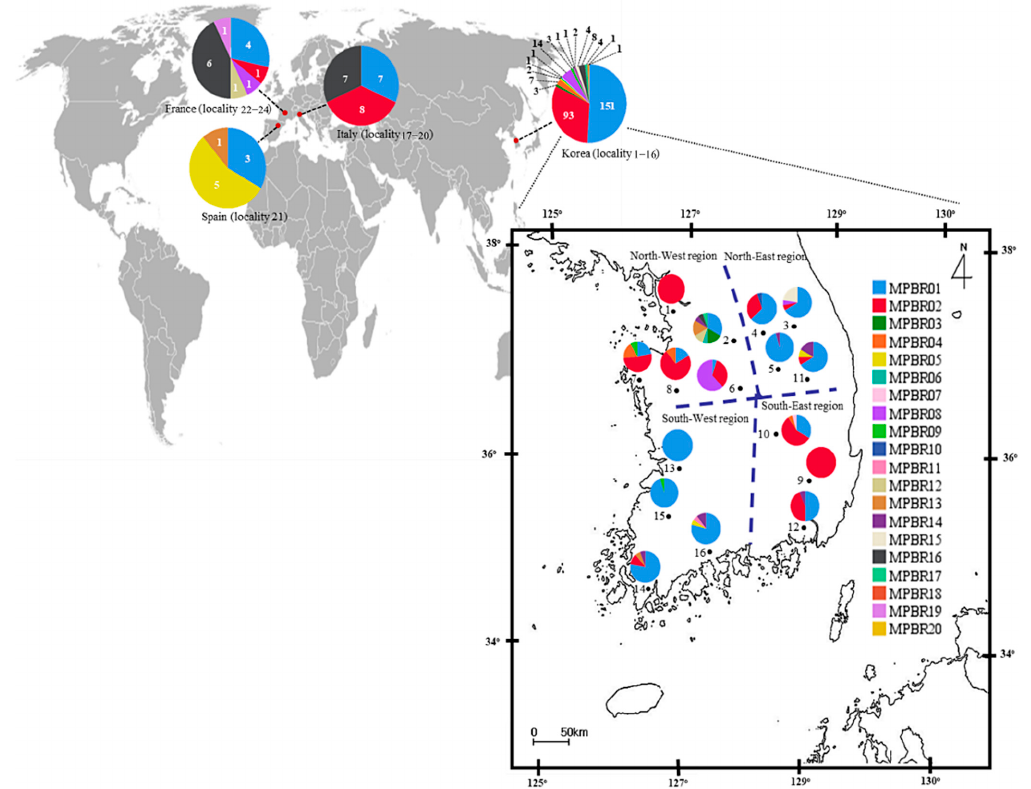
Figure 3. Distribution of the haplotypes defined based on the concatenated sequences of 658 bp fragments of the COI and Region 5 of Metcalfa pruinosa . The general locality names are as follows: 1, Incheon (MPBR02, 15 individuals); 2, Yeoju (03, 3; 06, 1; 14, 2; 15, 3; 16, 1; 18, 1; and 20, 1); 3, Pyeongchang (01, 12; 02, 1; 08, 1; and 17, 4); 4, Wonju (01, 12; 02, 6; and 10, 1); 5, Danyang (01, 21; and 16, 1); 6, Goesan (01, 1; 02, 7; and 08, 13); 7, Taean (01, 5; 02, 12; 04, 4; and 09, 2); 8, Yesan (01, 3; 02, 13; and 04, 2); 9, Cheongdo (02, 17); 10, Sangju (01, 7; 02, 12; 04, 1; and 07, 1); 11, Yeongju (01, 8; 02, 1; 05, 1; and 16, 2); 12, Gimhae (01, 8; 02, 7; and 16, 1); 13, Iksan (01, 20); 14, Haenam (01, 14; 02, 2; 15, 1; and 16, 1); 15, Jangseong (01, 19; and 09, 1); 16, Suncheon (01, 15; 05, 1; 11, 1; and 16, 2); 17 − 20, Italy (01, 7; 02, 8; and 16, 7); 21, Spain (01, 3; 05, 5; and 13, 1); and 22 − 24, France (01, 4; 02, 1; 08, 1; 12, 1; 16, 6; and 19, 1). The dotted lines on the map of Korea indicate the division into four regions for the population genetic